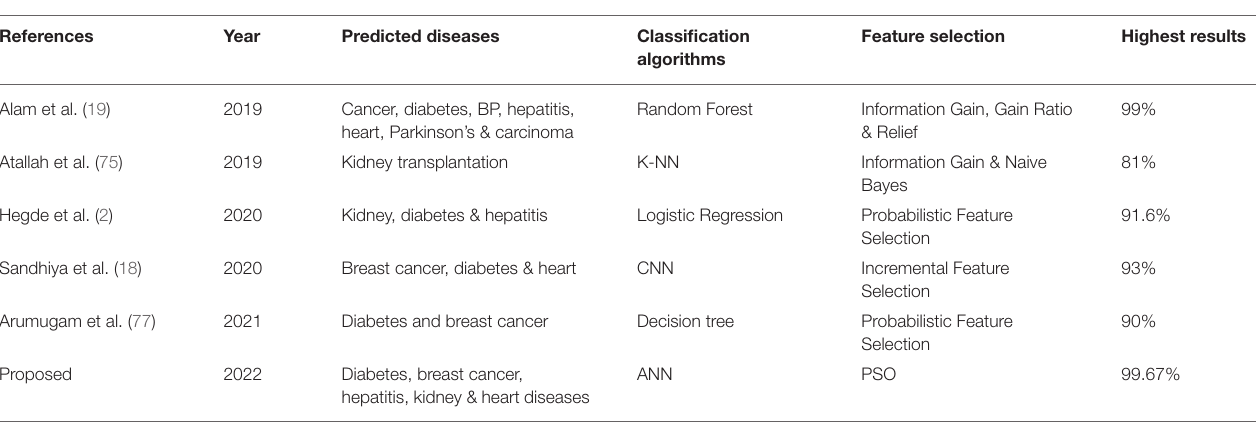
TABLE 5 | Comparative